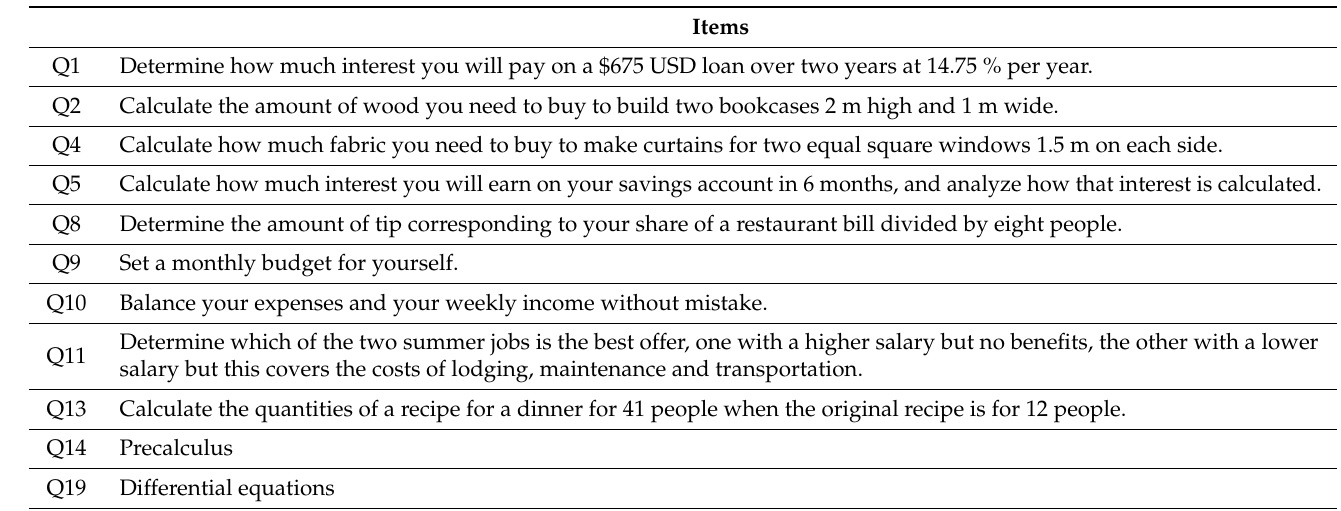
Table 2. Items deleted from the instrument to improve CFA model fit. Items